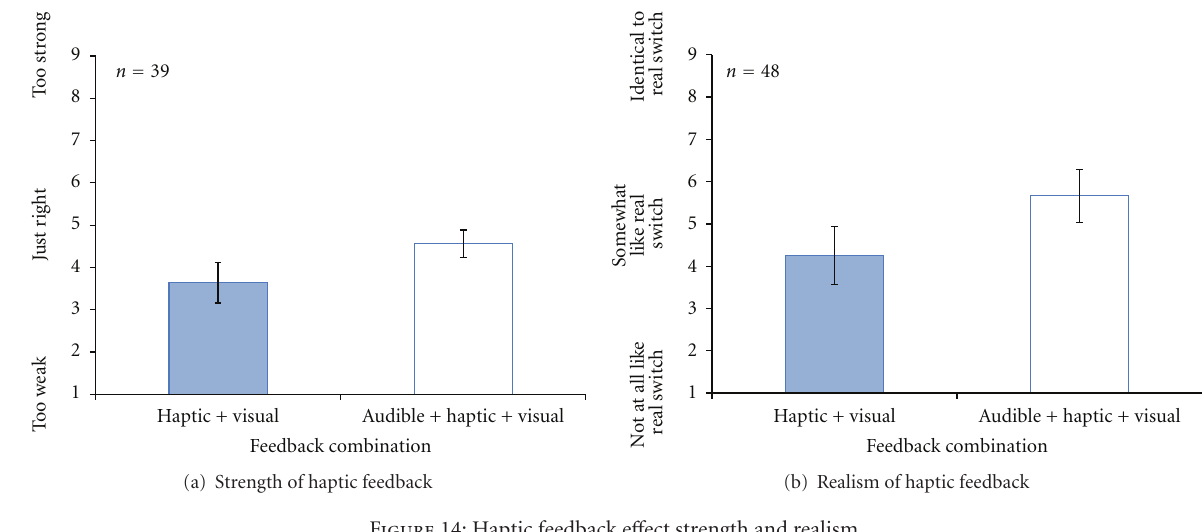
Figure 14: Haptic feedback e ff ect strength and realism.